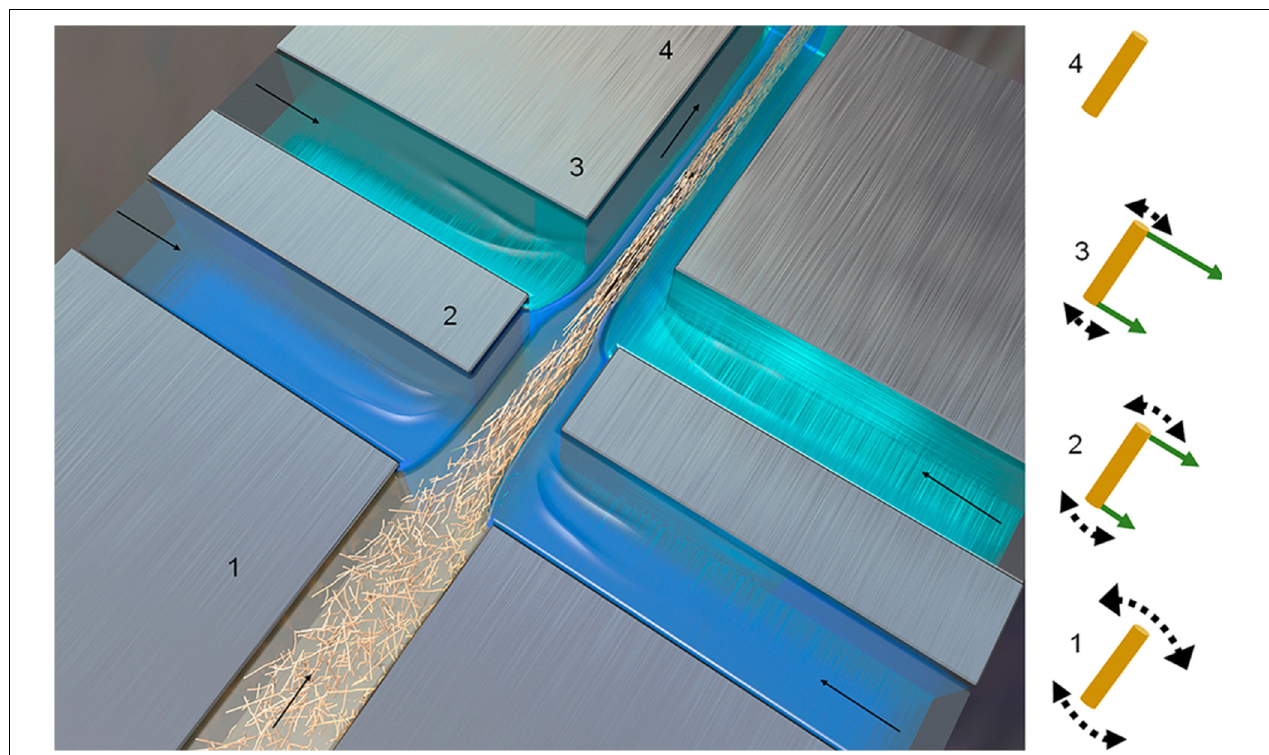
FIGURE 11 | Schematic of double flow-focusing channel used for CNF assembly (Mittal et al.,